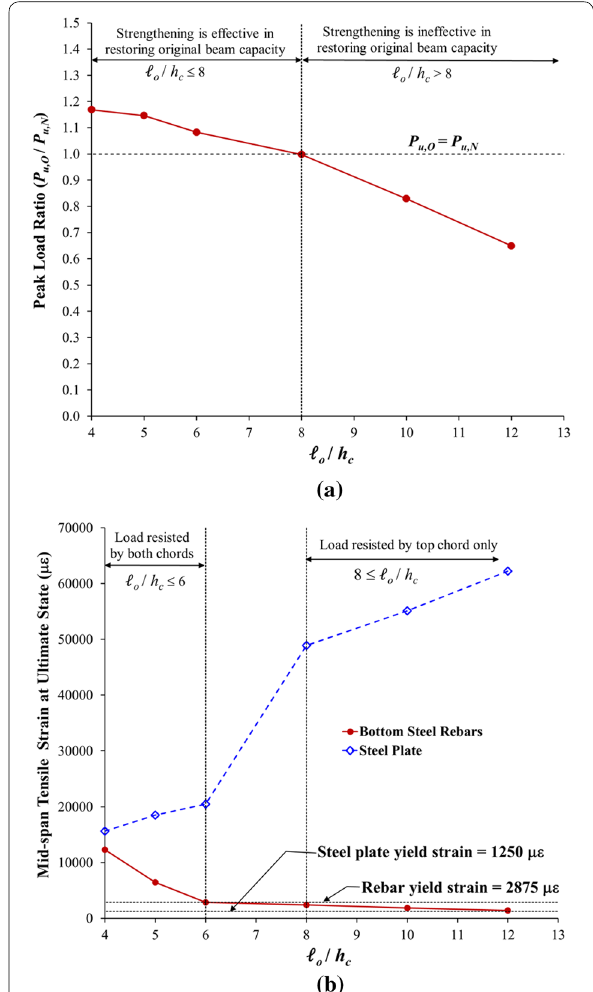
Fig. 20 Effect of opening size on performance of beams strengthened with scheme‑4 and loaded at mid‑span (based on FE analysis): a with respect to peak load and b with respect to strain in bottom steel rebars and steel plate at